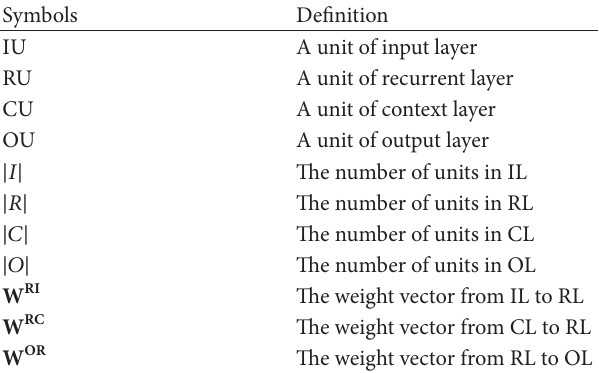
Table 5: Definition of SRNN